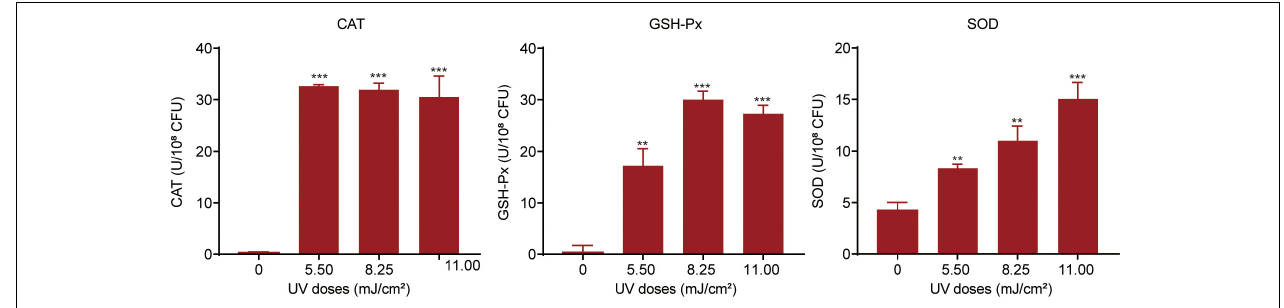
FIGURE 4 | Oxidative stress response in P. aeruginosa during UV exposure. Bacterial suspensions were sonicated at 20 kHz for 10 min and then centrifuged at 5,000 × g at 4 ◦ C for 3 min. The levels of catalase (CAT), glutathione peroxidase (GSH-Px) and superoxide dismutase (SOD) in the supernatants were measured. Data are shown as the mean ± standard deviation (s.d.). ( n = 3). ** P < 0.01 and *** P < 0.001; assessed by Student’s t